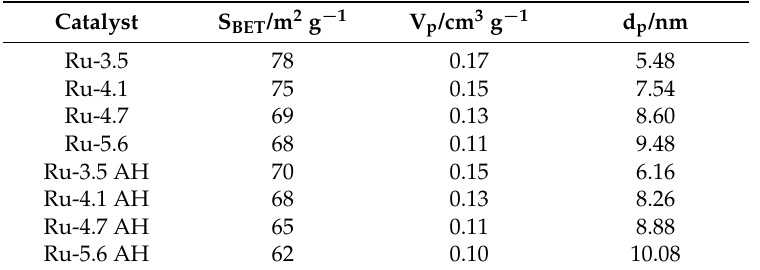
Table 2. Textural properties of the Ru catalysts with the different particle size before and after catalytic experiments, including specific surface area (S BET ), pore volume (V p ) and pore diameter (d p ).